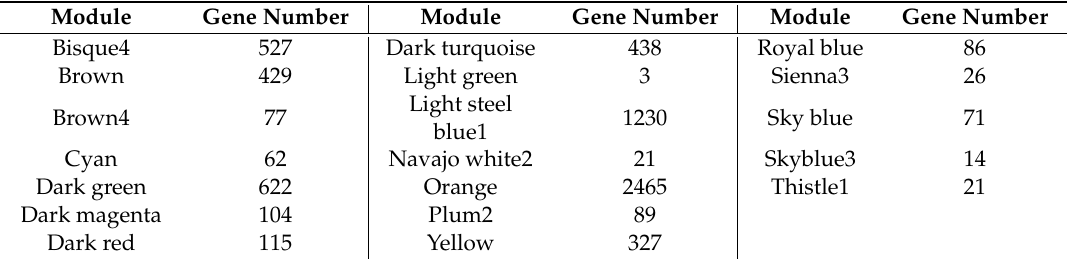
Table 1. Modules identified by weighted correlation network analysis